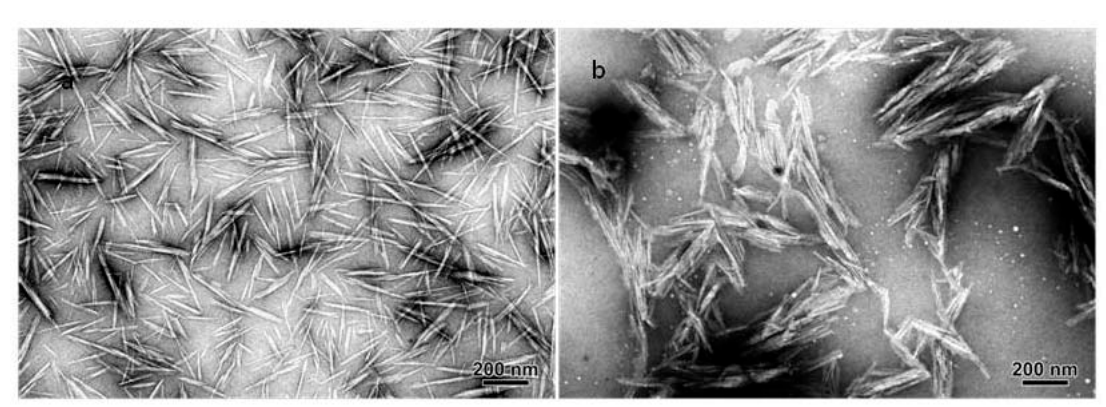
Figure 5. Transmission electron micrograph of ramie cellulose whiskers: (a) ungrafted and (b) recovered after ROP/grafting reactions and Soxhlet extraction